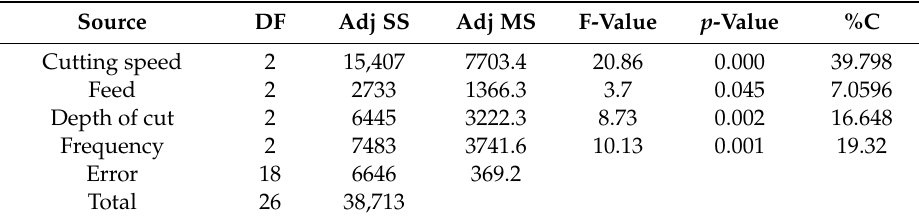
Table 6. Analysis of variance of means for and power